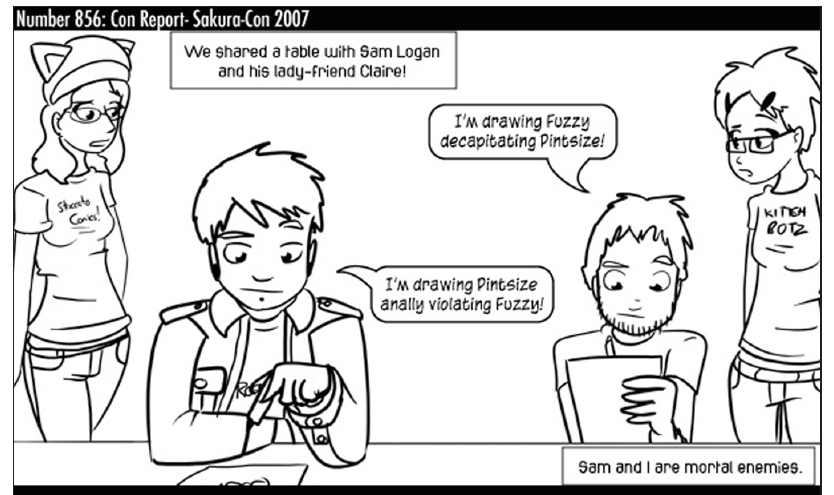
Figure 2: Jacques, J (n.d.) Con Report-Sakura Con 2007. Questionable Content